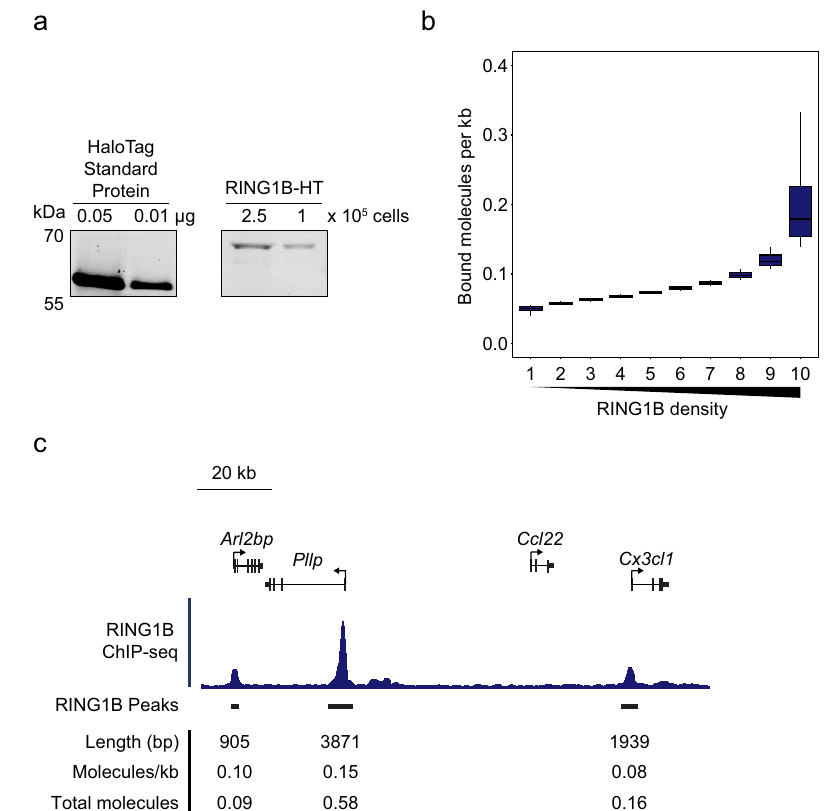
Fig. 3 RING1B has low target site occupancy. a An example of an in-gel fl uorescence image of TMR-labelled HaloTag Standard Protein loaded in known quantities (left panel) and RING1B-HT-TMR from whole-cell lysates of a known number of cells (right panel). Fluorescence intensity from n = 3 biological replicates was used to quantify the number of molecules present 81 . Source data are provided as a Source Data fi le. b A box plot illustrating the number of RING1B molecules that are estimated to be bound per kilobase of DNA at RING1B peaks from ChIP-seq in ESCs 79 . Read distributions aggregated from n = 3 biological replicates of RING1B ChIP-seq were used to segregate bound RING1B molecules into density deciles over RING1B peaks (18,643). Boxes represent the interquartile range (IQR), the middle line corresponds to the median, and whiskers extend to the largest and smallest values no more than 1.5 x IQR from the box. Values outside of this range are not plotted, but are included in all analyses. Source data are provided as a Source Data fi le. c A genomic snapshot of RING1B ChIP-seq illustrating the varying distribution of RING1B binding between individual peaks. The values shown below indicate the length of the RING1B peak, the estimated density of RING1B molecules bound at each peak, and the estimated number of molecules bound per allele to each peak assuming a 2n